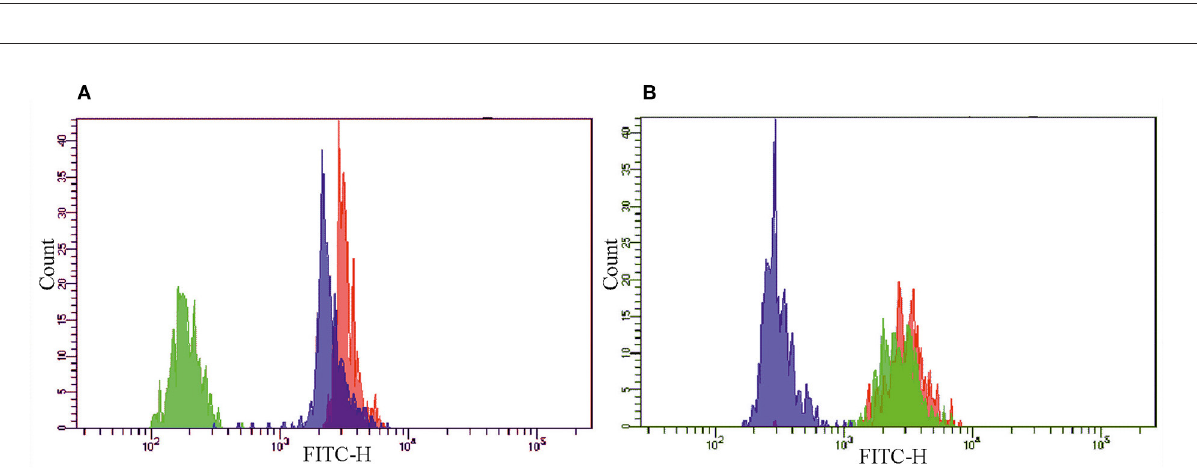
FIGURE2 The histograms of the fluorescence intensity of the A5 (red), C4 (green) and E5 (blue) beads, conjugated to monoclonal antibodies clones MOH 328 (anti-pCRP/mCRP), 8C8 (anti-mCRP), MOH372 (anti-pCRP), respectively, in the presence of (A) pCRP or (B) mCRP in concentration 0.25 mg/L and polyclonal FITC-labeled antibody to CRP (GAHCRP-FITC). mCRP, monomeric C-reactive protein; pCRP, pentameric C-reactive protein.